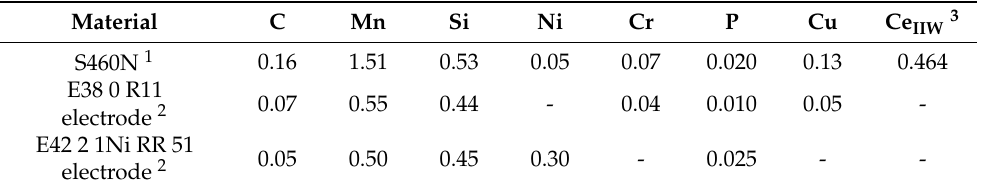
Table 1. The chemical compositions of the used materials (wt.%). Material C